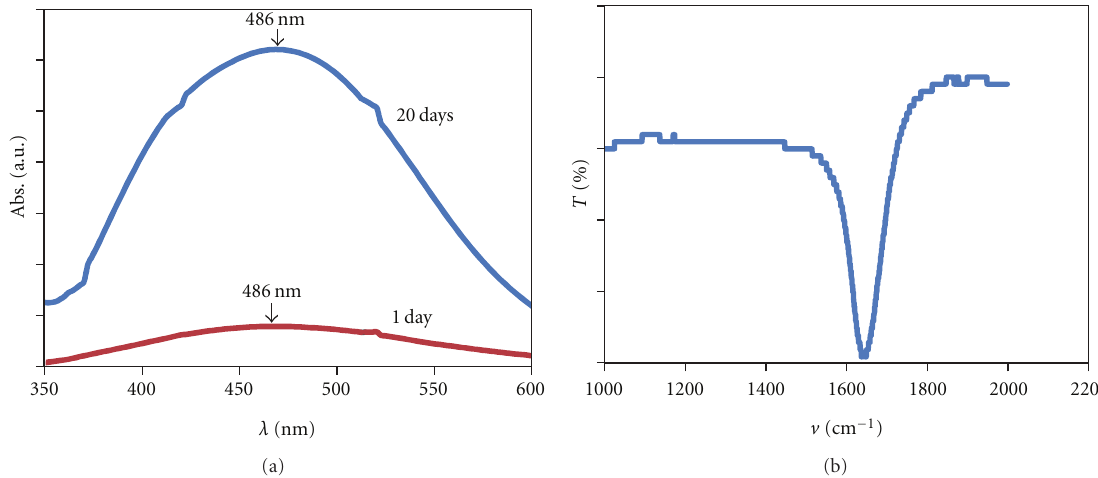
Figure 5: UV-Vis spectra recorded with respect to time after the reaction for 24 h and 20 days of contact of yeast supernatant with 1mM AgNO 3 (a). FTIR spectrums recorded from a drop-coated film of the AgNPs/supernatant (b).